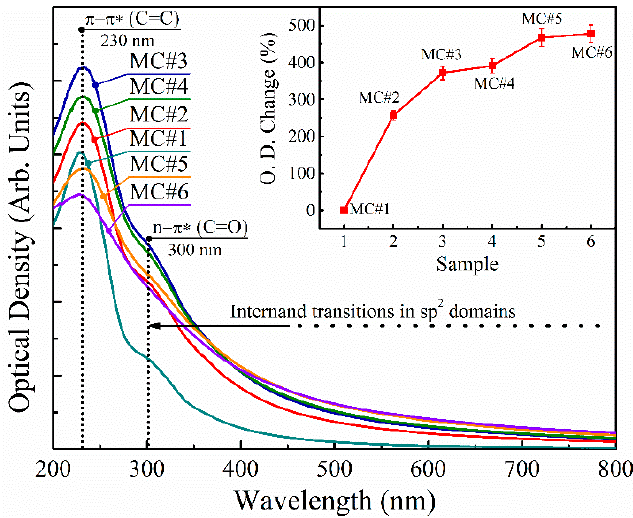
Figure 9 . UV-Vis spectra of the MC#1–MC#6 aqueous suspensions of 0.01 wt.% concentration. Inset: the increase in the optical density in the visible range of spectra (380–750 nm) from MC#1 to